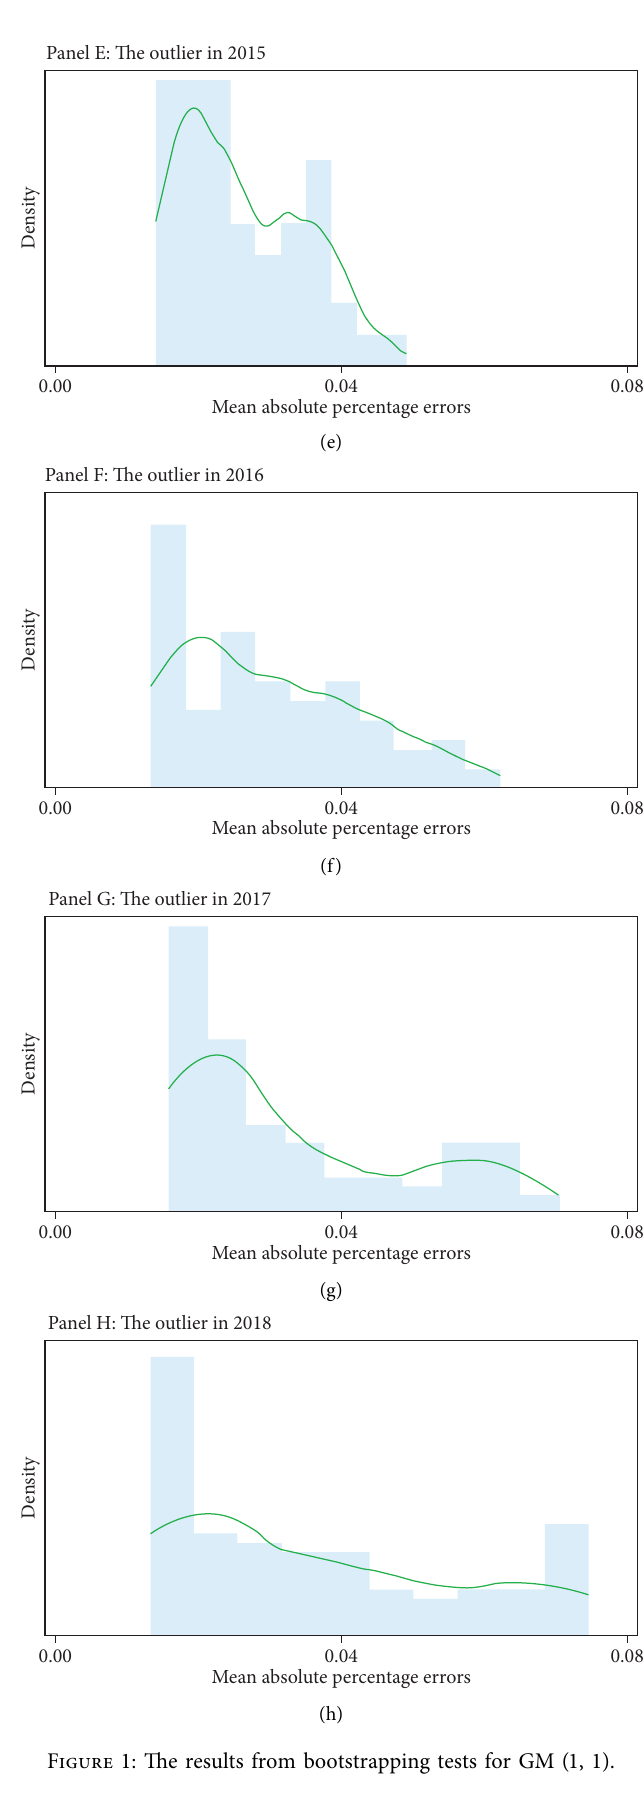
Figure 1: Te results from bootstrapping tests for GM (1,